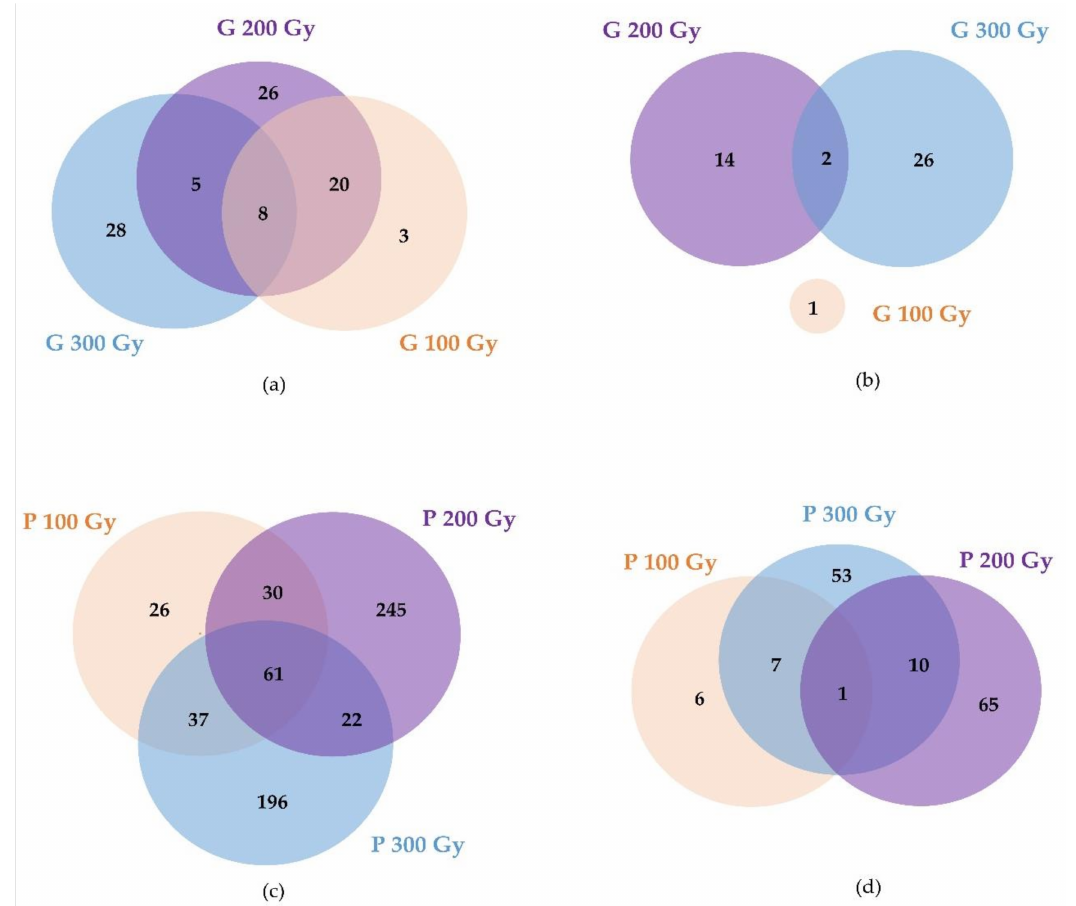
Figure 2. Venn diagram showing the number of common and specific differently expressed genes (DEGs) by gamma-ray (top) and proton-beam (bottom) treatments. ( a , c ) Up-regulated, ( b , d )